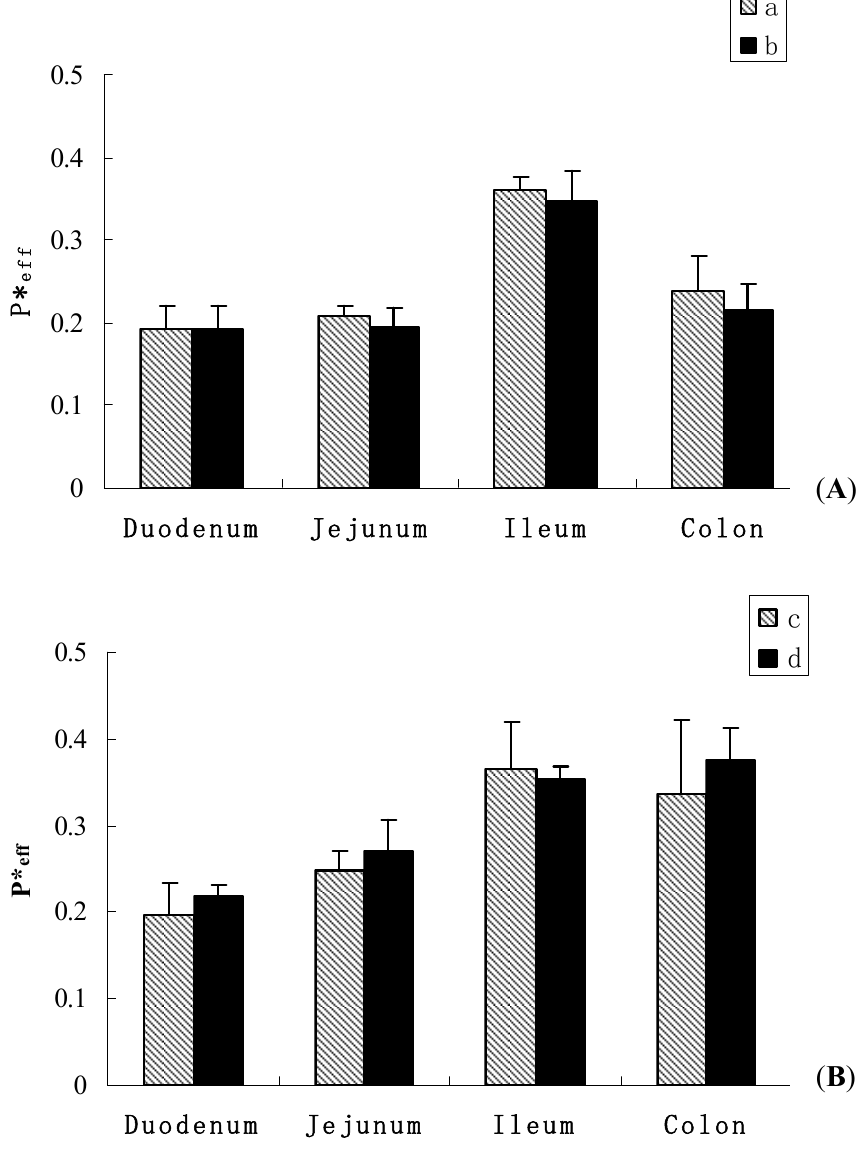
Figure 3. Effective permeability of SSA and SSD in different intestinal segments ( x ± s, n = 4). Figure ( A ) SSA; ( a ) alone; ( b ) co-administration with paeoniflorin; Figure ( B ) SSD; ( c ) alone; ( d ) co-administration with paeoniflorin.